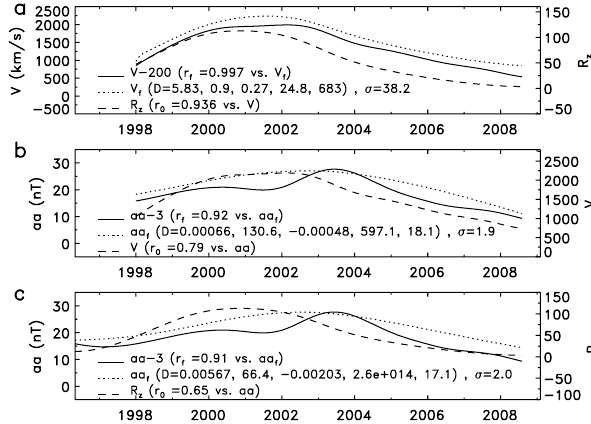
Fig. 9. Similar to Fig. 8 but using the double-decay model (12). (a) The correlation coefficient of V (solid, shifted downward by 200 for clarity) with the reconstructed series V f (dotted) from R z (dashed) by Eq. (12) is now r f = 0 . 997. (b) The correlation co- efficient of aa (solid, shifted downward by 3 for clarity) with the reconstructed series aa f (dotted) from V (dashed) by Eq. (12) is now r f = 0 . 92. (c) The correlation coefficient of aa (solid, shifted downward by 3 for clarity) with the reconstructed series aa f (dot- ted) from R z (dashed) by Eq. (12) is now r f = 0 .